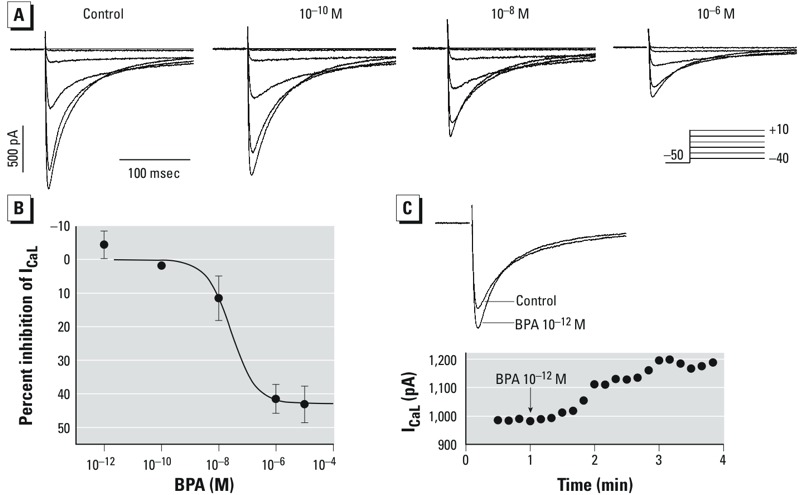
Effect of BPA on the ICaL in female rat ventricular myocytes shows a monotonic dose response. IC50, median inhibitory concentration. (A) Representative ICaL recorded from the same myocyte before (control) and after exposure to BPA (10–10, 10–8, or 10–6 M). Inset: voltage clamp protocol. (B) Dose response of the inhibition of ICaL by BPA; n = 7, 5, 7, 4, and 6 for 10–12, 10–10, 10–8, 10–6, and 10–5 M BPA, respectively. Data are fitted with the Hill equation: Percent inhibition = maximum inhibition/(1 + IC50/[BPA]), where maximum inhibition = 43%, and IC50 = 27.4 nM. Values are mean ± SE. (C) Example of a small but reproducible increase of ICaL after exposure to 10–12 M BPA. Top, ICaL recorded at 0 mV; bottom, time course of the observed stimulatory effect. All currents were recorded at steady-state following BPA treatment.